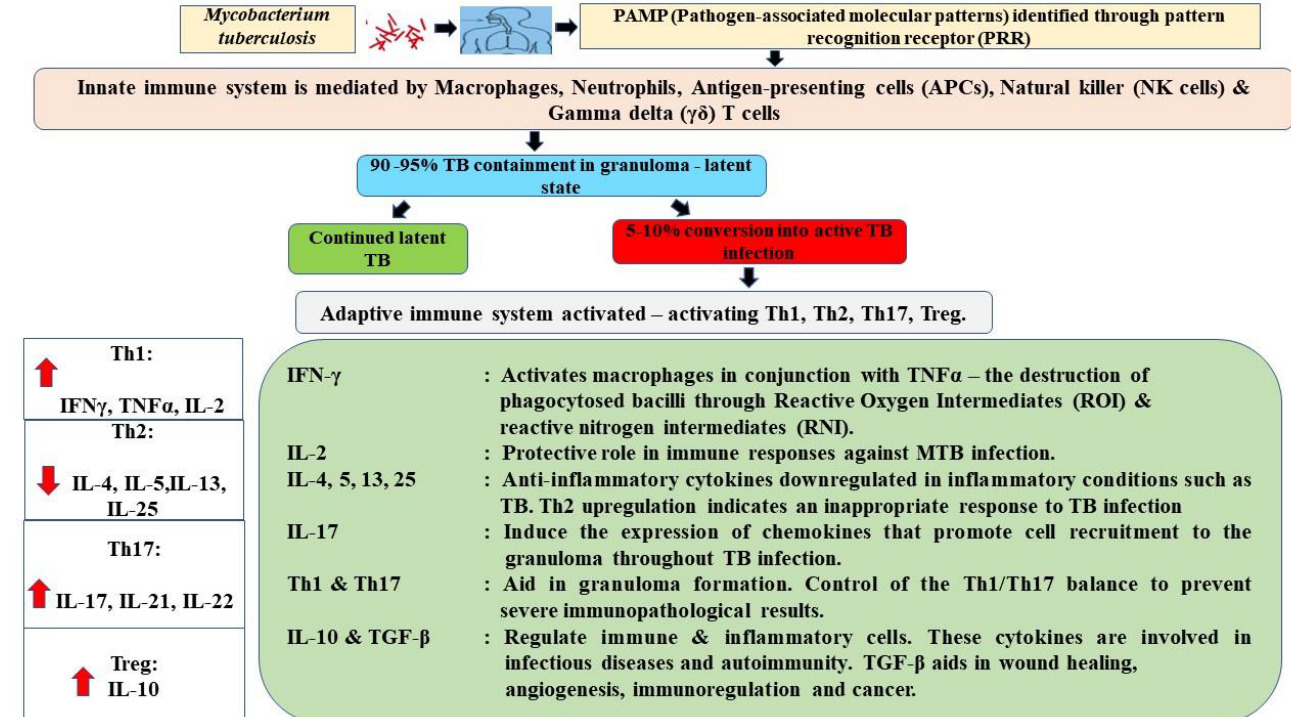
Figure 3. Immune response profiles during tuberculosis infection. Mycobacteria encounter alveolar